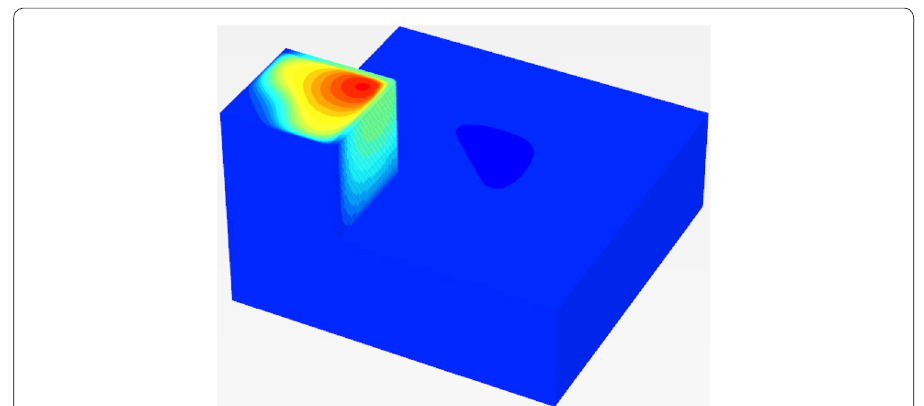
Fig. 25 Vertical displacement contour of Case 4